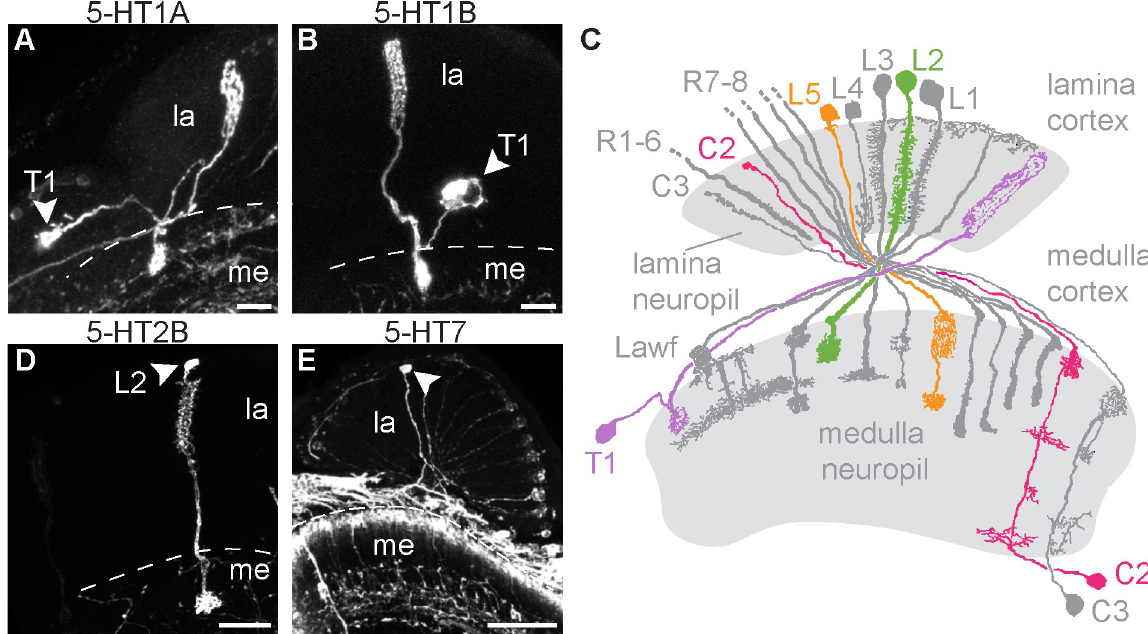
Fig 1. Lamina neurons including T1 and L2 express serotonin receptors. ( A-E ) Serotonin receptor MiMIC-T2A-GAL4 lines were crossed to UAS-MCFO-1 to sparsely label individual cells in the lamina. Cell bodies are indicated by an arrowhead. 5-HT1A ( A ) and 5-HT1B ( B ) MCFO crosses revealed cells with morphologies identical to T1 neurons. ( C ) A diagram showing lamina neurons adapted from [80] highlights L2 (green), L5 (orange), T1 (purple), and C2 (pink). ( D ) 5-HT2B > MCFO labeled cells were morphologically identical to L2 neurons. ( E ) 5-HT7 > MCFO-1 labeled neurons possibly representing L5 lamina monopolar cells. Scale bars are 20 μ m and N = 9–31 brains imaged per receptor subtype. Due to the nature of stochastic labeling, some cell types were observed in only a subset of brains: 22/31 ( A ), 10/11 ( B ), 9/9 ( D ), and 7/13 ( E